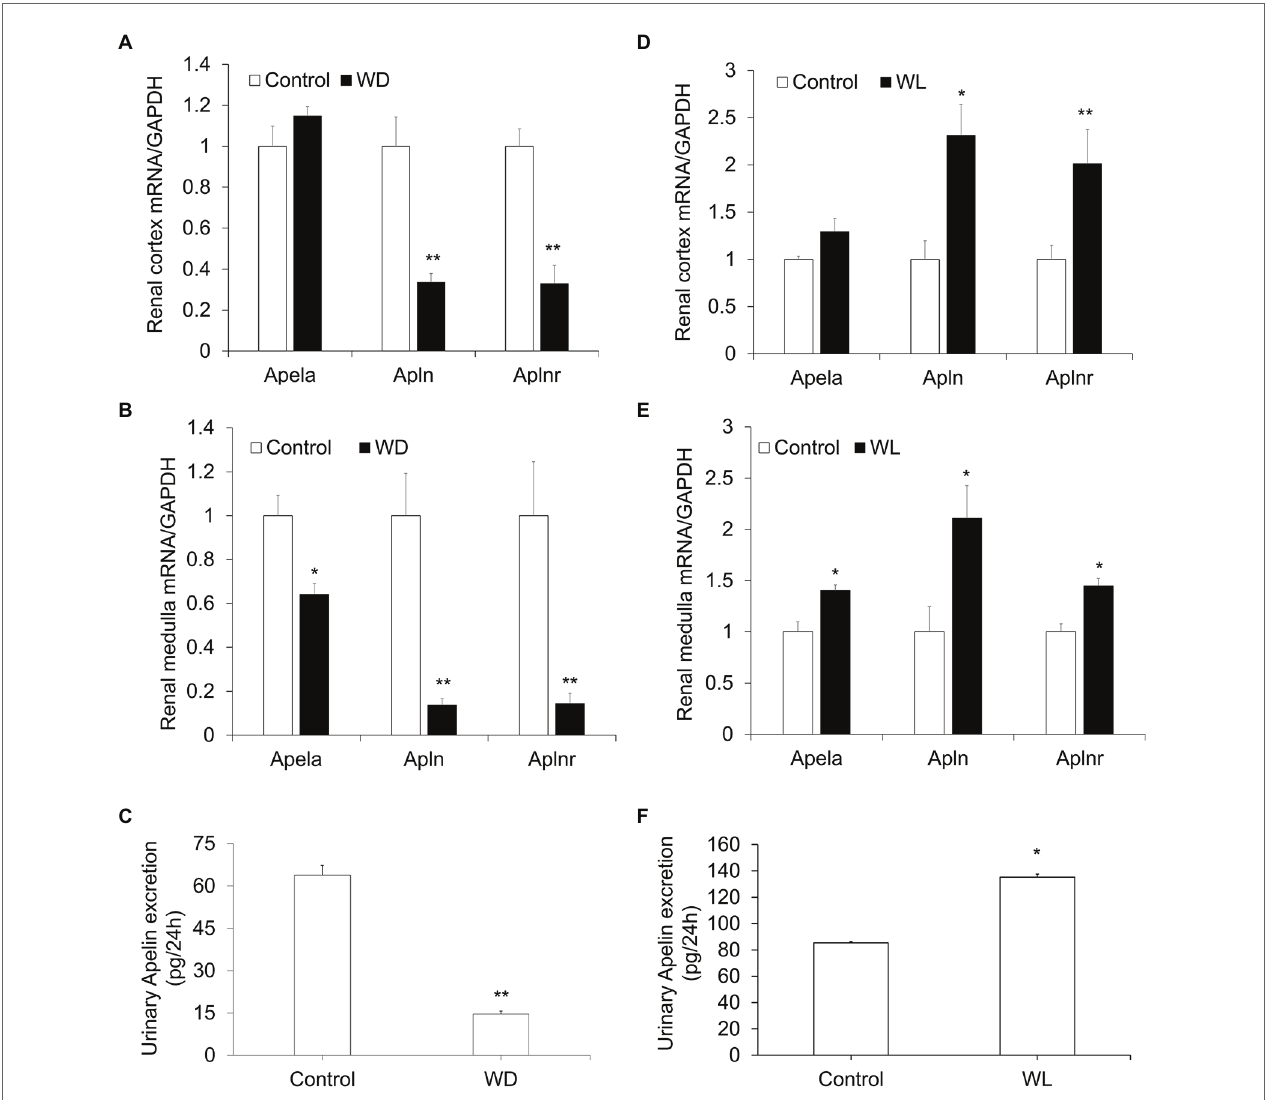
FIGURE 1 | The response of the renal apelinergic system to water deprivation (WD) and chronic water loading (WL) in mice. (A,B) Quantitative reverse transcriptase PCR (qRT-PCR) analysis of renal Apln , Apela , and Aplnr mRNA expression in the kidney cortex (A) and medulla (B) in WD mice, expression was normalized by GAPDH . (C) A 24-h urinary apelin excretion in WD mice. (D,E) qRT-PCR analysis of renal Apln , Apela , and Aplnr mRNA expression in kidney cortex (D) and medulla (E) in chronic WL mice. The expression was normalized by GAPDH . (F) 24-h urinary apelin excretion in WL mice. n = 5 per group. Data are mean ± SEM. * p < 0.05 and ** p < 0.01 vs.